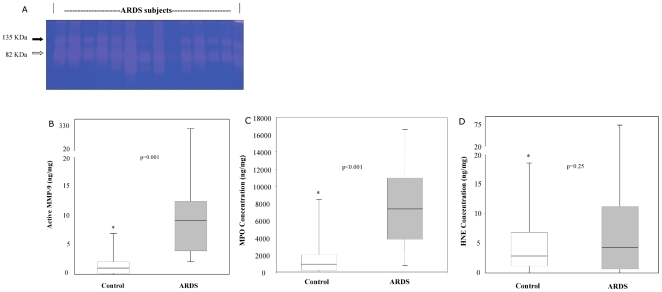
MMP-9, MPO and HNE levels in early pediatric ARDS.A. Zymogram (7.5% SDS non-reduced gel) demonstrates robust gelatinase activity in tracheal aspirates from ARDS subjects. Each lane represents a sample obtained from separate ARDS subjects at 48 hours of disease onset and intubation. The higher molecular weight band at 135 kDa (black arrow) likely represents lipocalin:MMP-9 complexes, while the 82 KDa band (white arrow) corresponds with active MMP-9 isoforms. B. Endogenously active MMP-9 levels measured in tracheal aspirates of ARDS subjects at 48 hours of disease onset and intubation were elevated (16-fold) compared with control subjects (*p = 0.001). Boxes represent 25th to 75th percentile range, with the midline indicating the median; bars represent the highest and lowest values. C. MPO concentrations were elevated (7-fold) in ARDS subjects compared to controls at 48 hours of intubation (*p<0.001). Boxes represent 25th to 75th percentile range, with the midline indicating the median; bars represent the highest and lowest values. D. HNE concentrations were elevated (3-fold) in ARDS subjects compared to controls at 48 hours of intubation (*p = 0.25). Boxes represent 25th to 75th percentile range, with the midline indicating the median; bars represent the highest and lowest values.